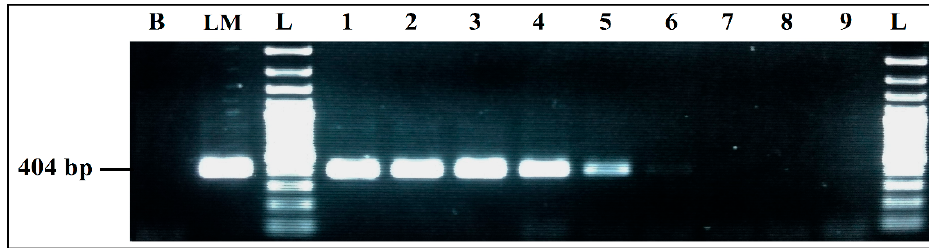
Figure 4. Detection sensitivity of L. monocytogenes primers LM 404 bp, in Simplex PCR. B, negative control; LM, positive control L. monocytogenes 936 CECT; L, 100 bp DNA ladder; lane 1 to 6, PCR results from 359 pg/ μ L to 0.004 pg/ μ L DNA; lane 7 to 9, PCR results from 0.0004 pg/ μ L to 0.000004 pg/ μ L DNA; L, 100 bp DNA ladder.